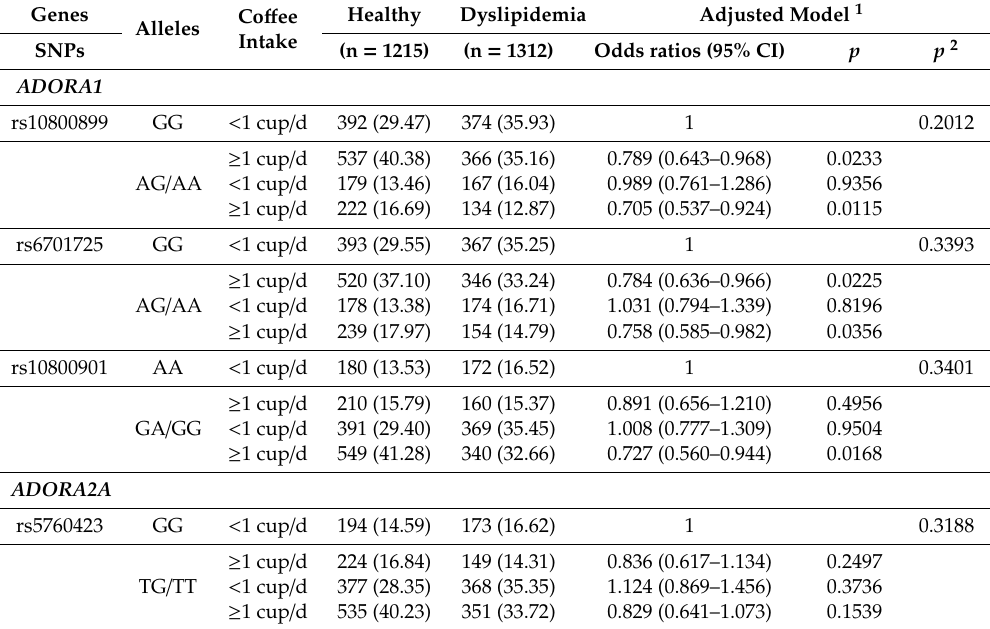
Table 5. Risk of dyslipidemia depending on the co ff ee intake and genotype in ADORA gene family in